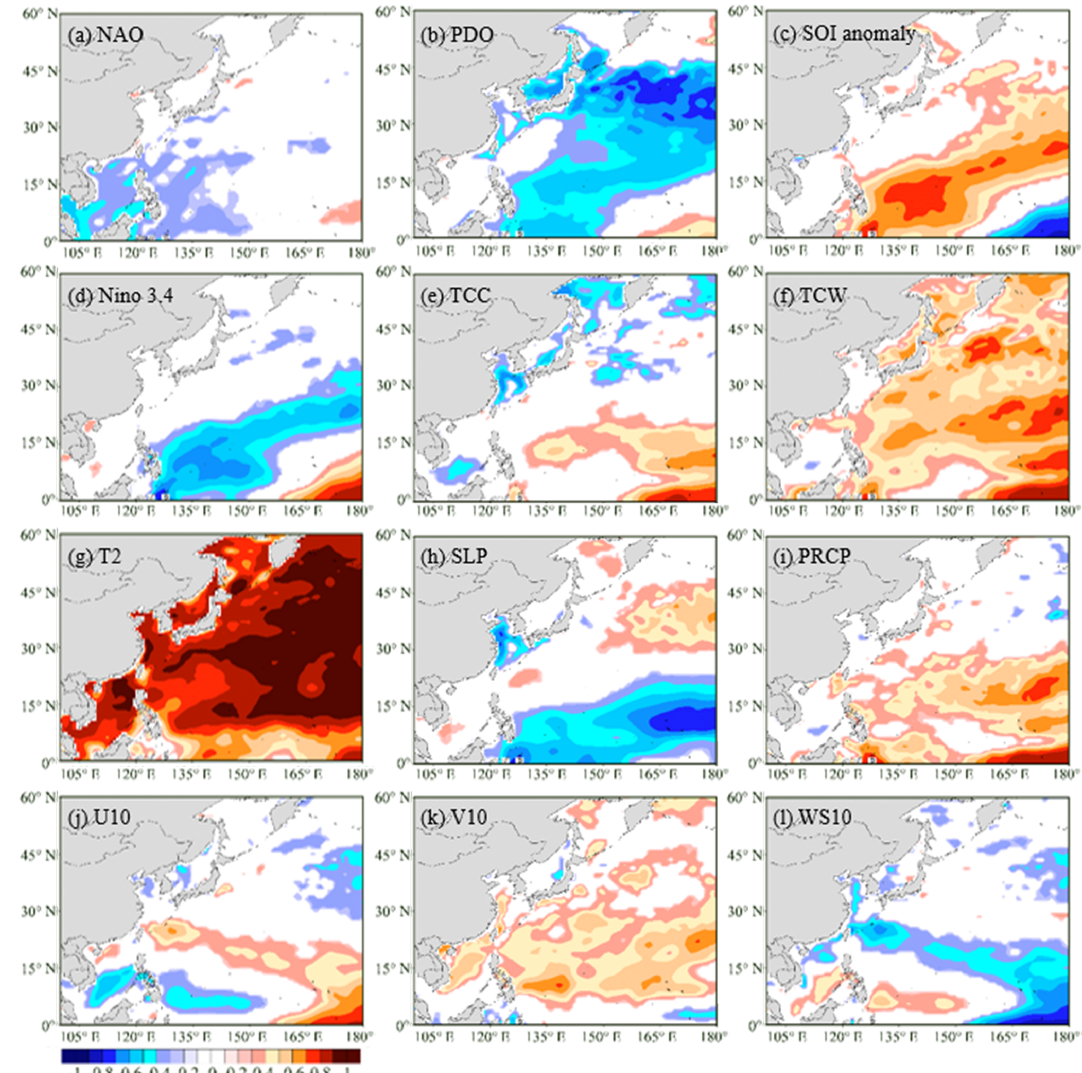
Figure 9. The correlation coefficient between SST and the atmospheric components (level of significance equal to